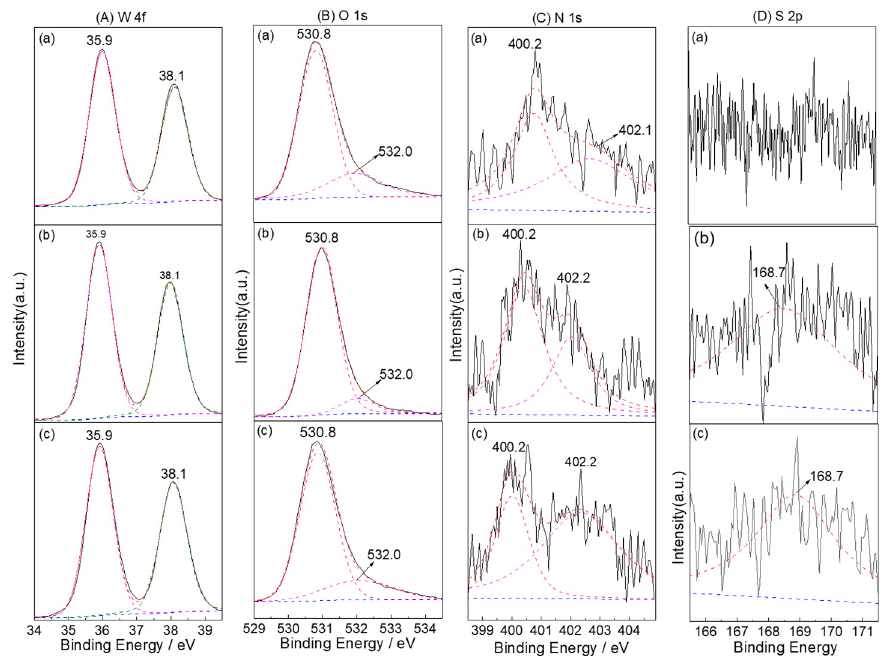
Figure 3. XPS spectra of ( a ) WO 3 − 5, ( b ) WO 3 − 10, and ( c ) WO 3 − 15 in ( A ) W 4f, ( B ) O 2p, ( C ) N 1s, and ( D ) S 2p regions. and ( D ) S 2p